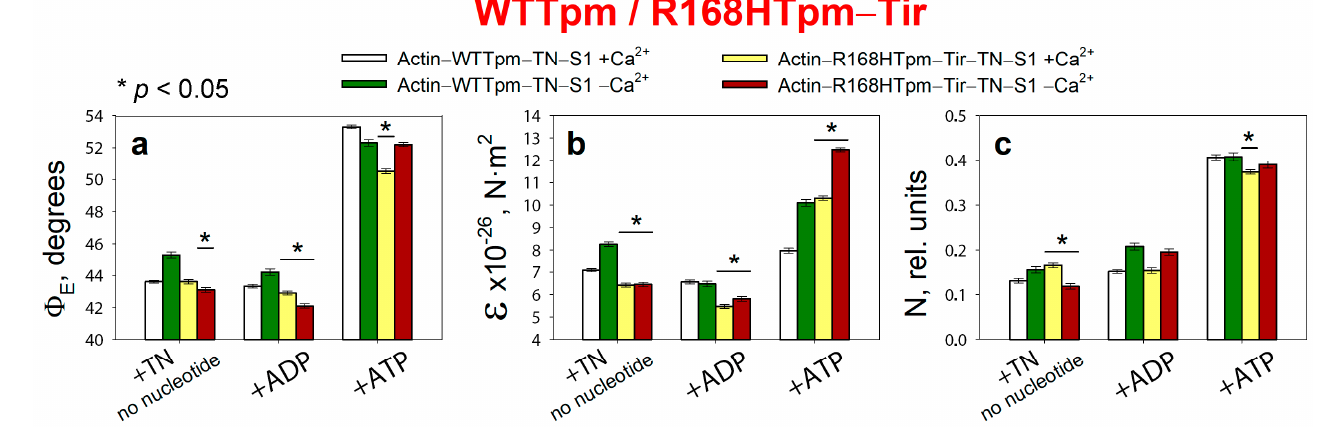
Figure 11. Effect of 5 μ M tirasemtiv (Tir) on the values of Φ E ( a ), ɛ ( b ), and N ( c ) of polarized fluorescence of S1-AEDANS in the presence of WTTpm or R168HTpm revealed in ghost muscle fibers under conditions simulating the sequential steps of the actomyosin ATPase cycle. The fluorescence parameters presented here are compared with the data obtained in the same experiment when the muscle fibers containing the WTTpm were used as a control. The data are presented as mean ± SEM. * p < 0.05 = difference between WTTpm and R168HTpm–Tir.